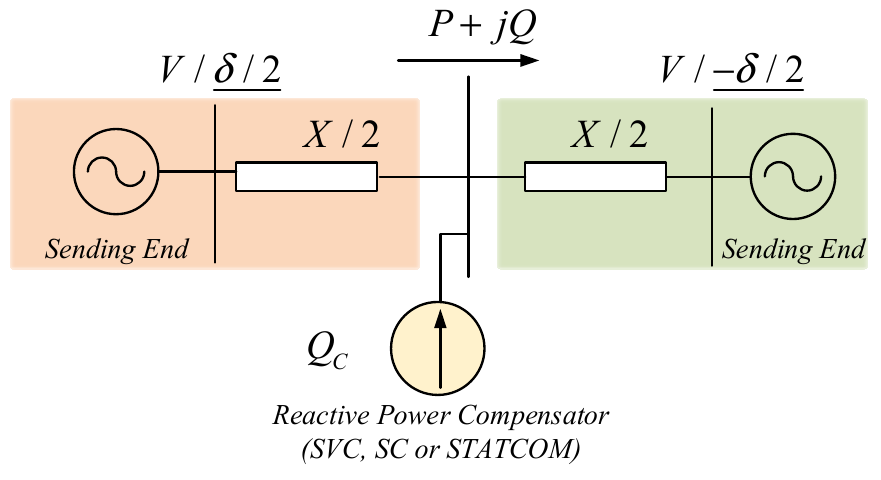
Figure 16. A two-machine system with mid-point